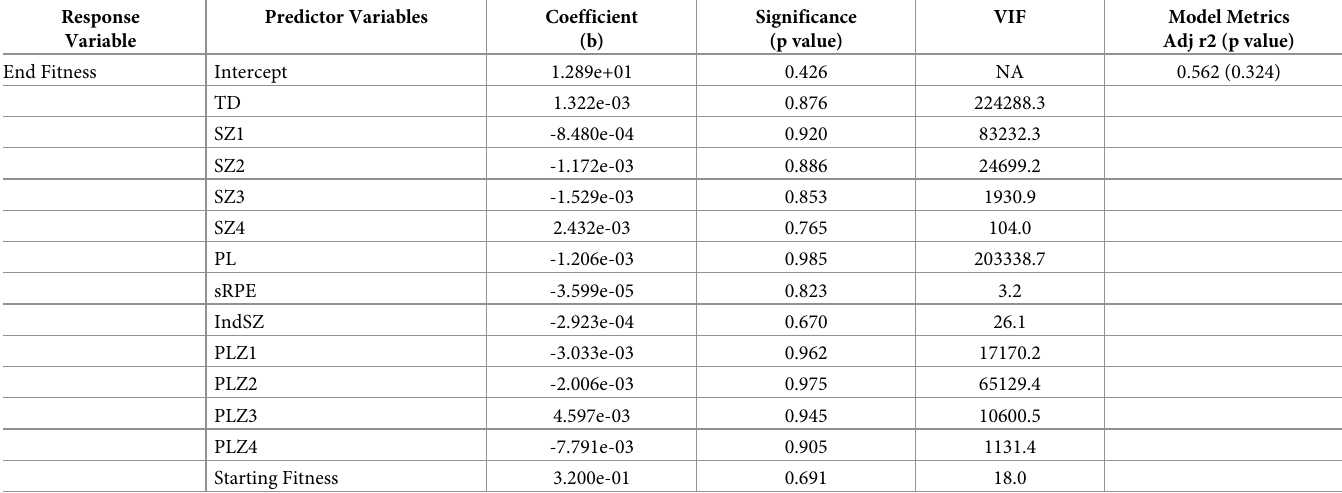
Table 4. Baseline multiple linear regression model with end fitness as the response variable, showing the calculated variable inflation factors (VIFs). Response